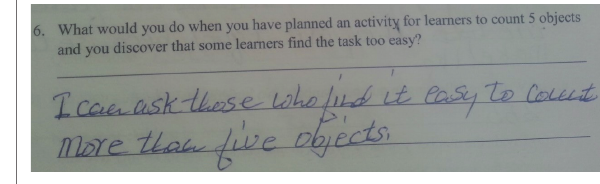
FIGURE 8: Response of Teacher 8.